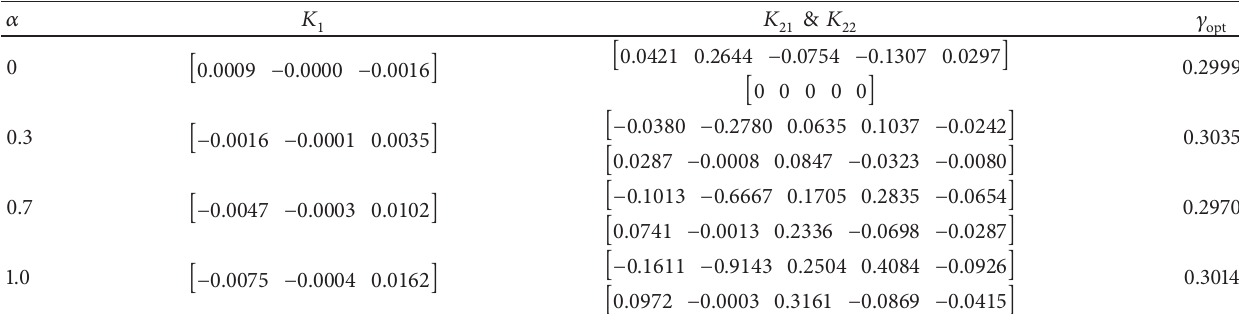
Table 1: Optimized 𝛾 opt and control parameters for various values of 𝛼